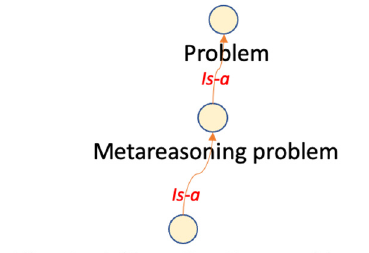
Figure 3. Class hierarchy according to (Conitzer and Sandholm 2003). Figure elaborated by the authors.